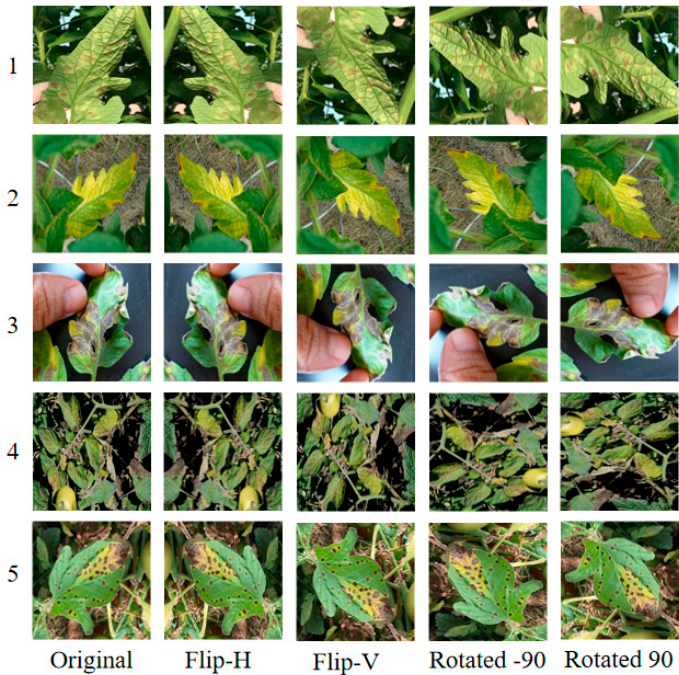
Figure 3. Traditional datasets augmentation method to expand tomatoes’ disease images.